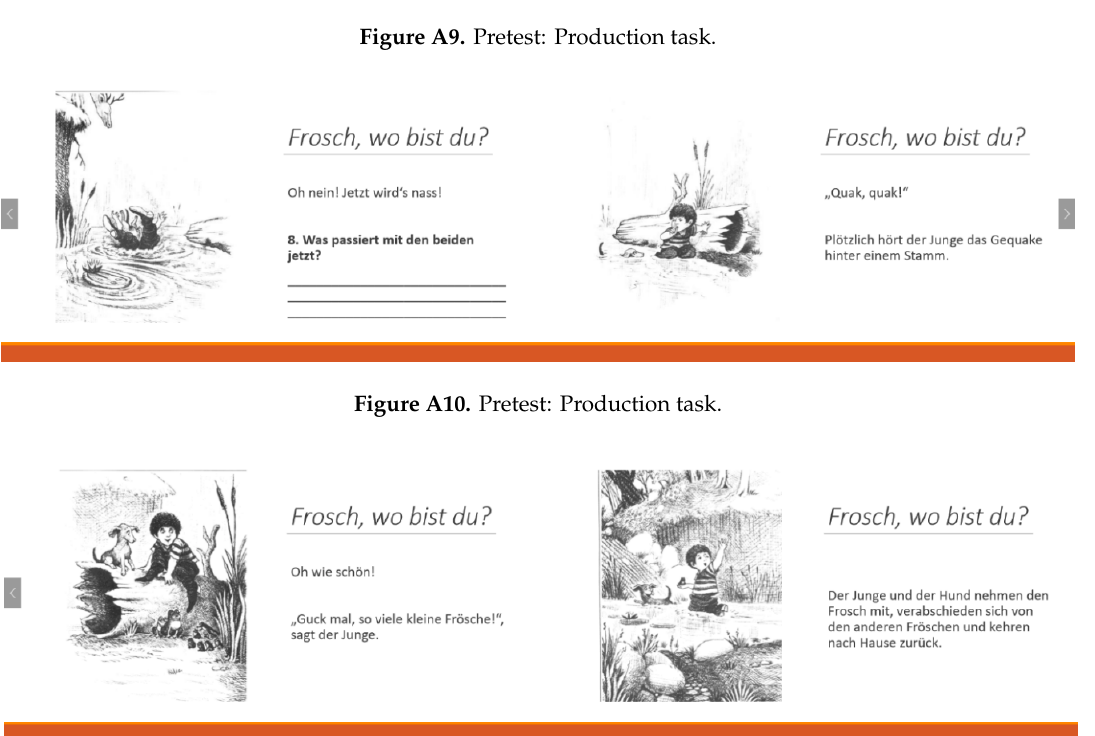
Figure A11. Pretest: Production task.